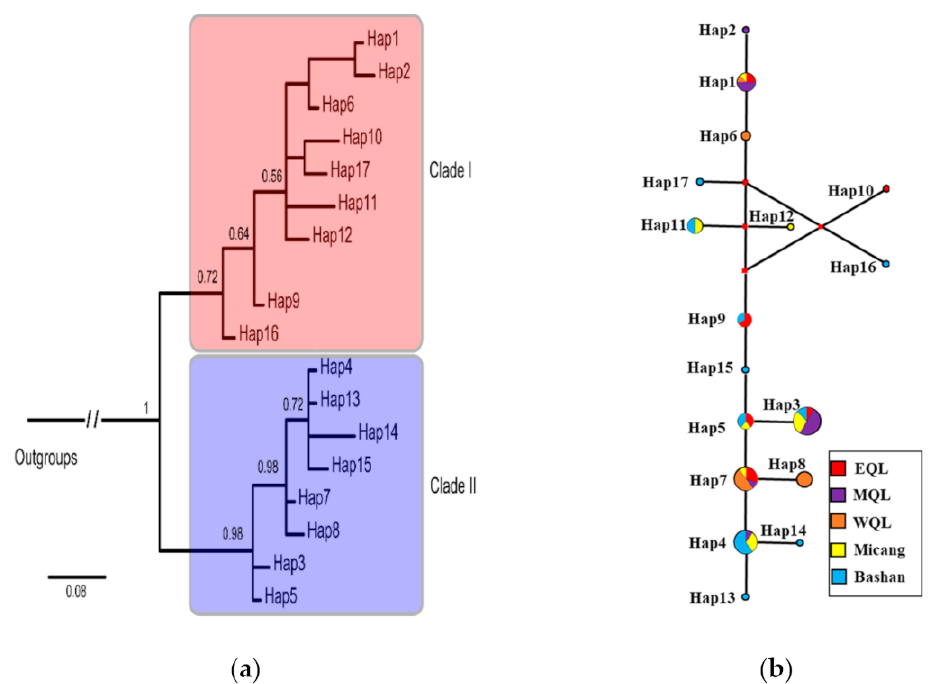
Figure 2. Phylogenetic tree and the median-joining network based on D-loop sequences of wild boar in QM. ( a ) A Bayesian 50% consensus phylogenetic tree for the 17 sampled haplotypes of Sus scrofa based on D-loop sequences. Numbers above the tree branches are the posterior probabilities. Numbers indicate haplotype codes (abbreviated to save space: e.g., H1 denotes haplotype 1). ( b ) The median-joining network. Dashes in network represent the corresponding mutation steps. The size of circles denotes the haplotype frequency. Small black circles indicated missing haplotypes that were not observed. The five populations are indicated by different colors. See Table 1 for definitions for EQL, MQL, WQL, Micang and